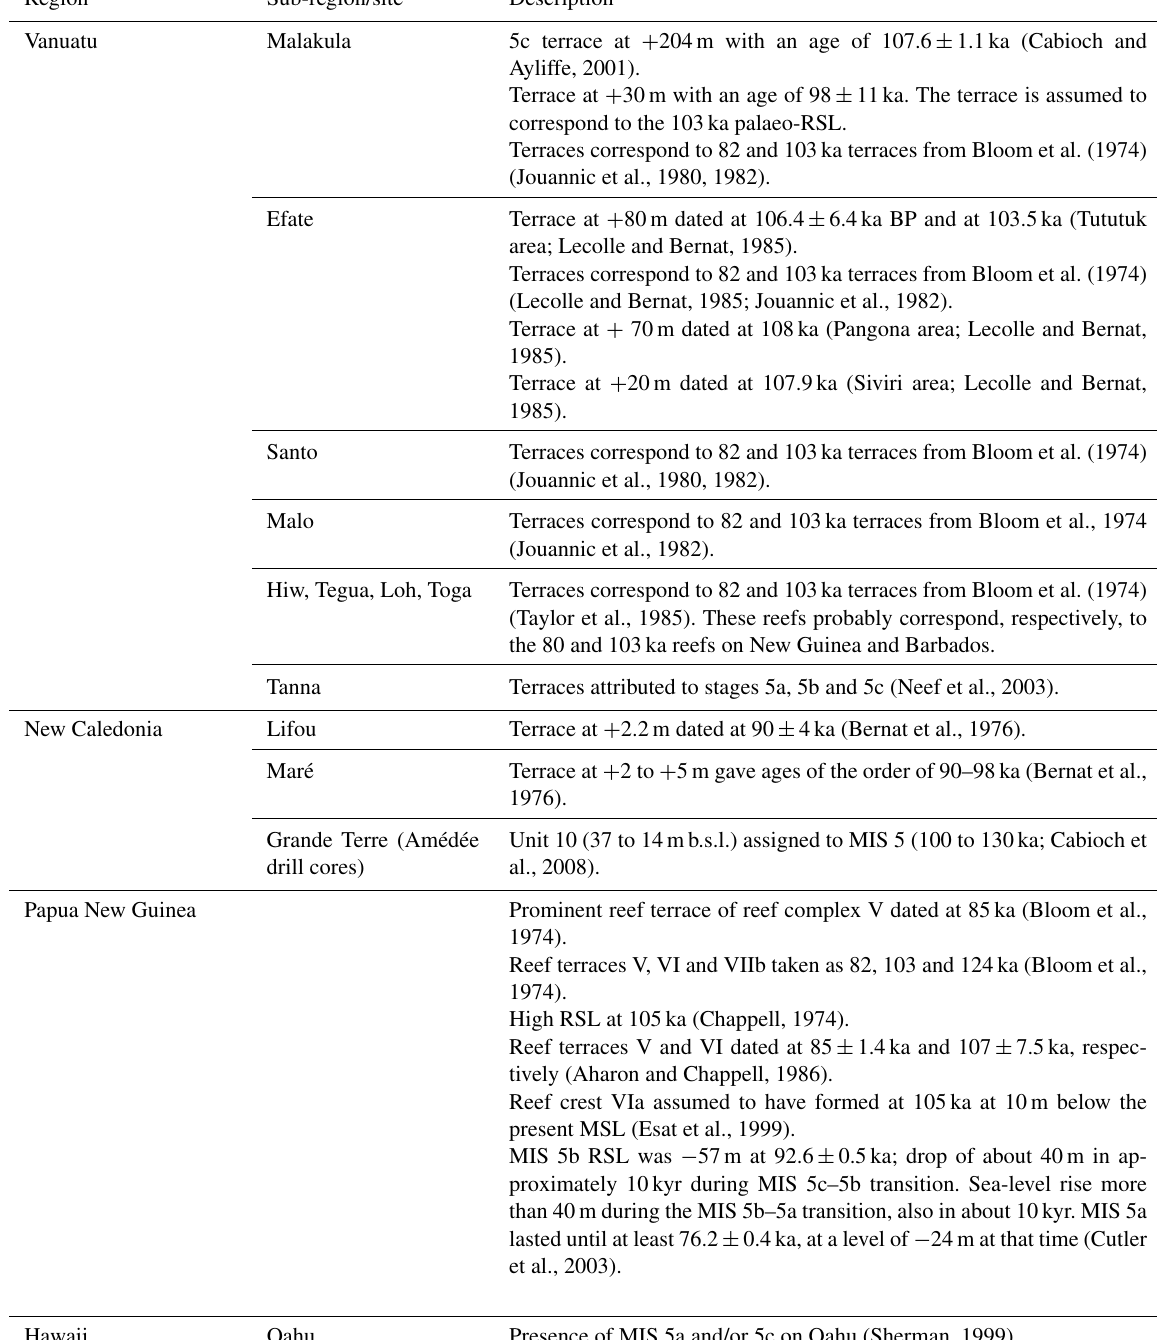
Table 5. MIS 5a and MIS 5c reviewed in this study.